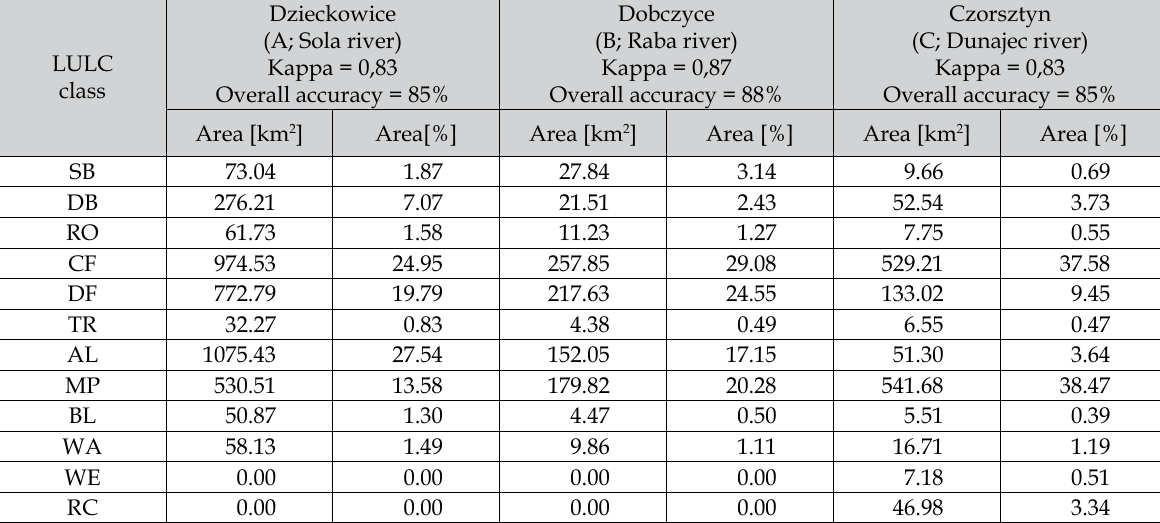
Table 2. the lUlc classes distribution in the analysed catchment areas obtained from GeoBia classification.